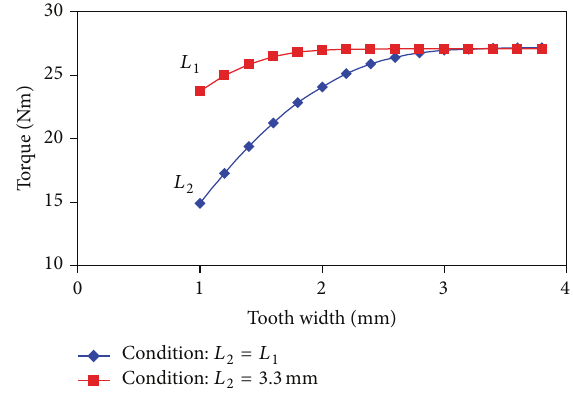
Figure 10: Variation of average output torque with fault-tolerant tooth width 𝐿 1 and armature tooth width 𝐿 2